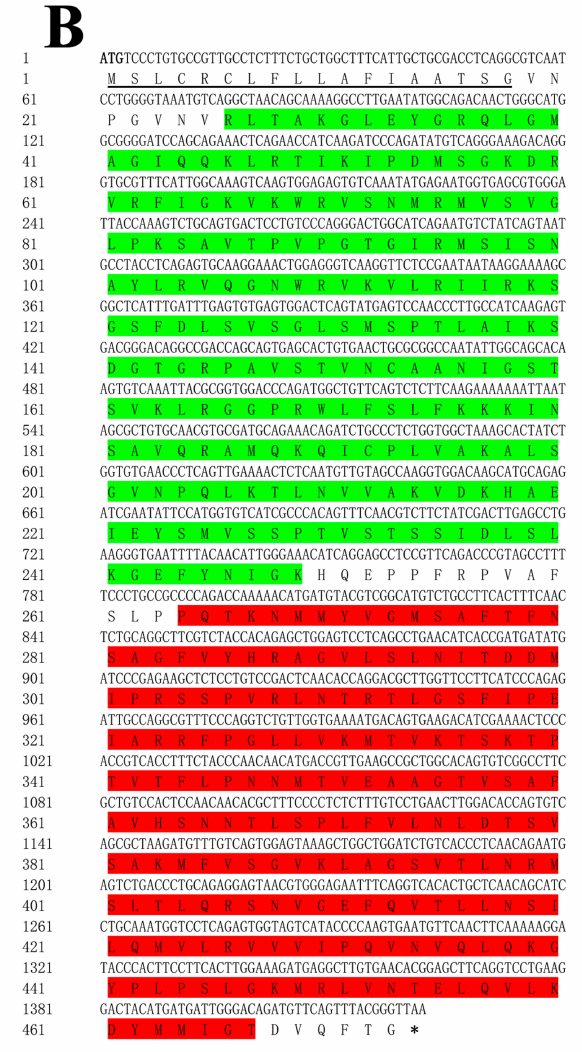
Figure 1. Sequence analysis of ToBPI1/LBP and ToBPI2/LBP. ( A , B ): nucleotide sequence and derived amino acid sequence of ToBPI1/LBP and ToBPI2/LBP. Signal peptide sequences are indicated by horizontal lines. The N-terminal domain is represented by green, and the C-terminal domain is represented by